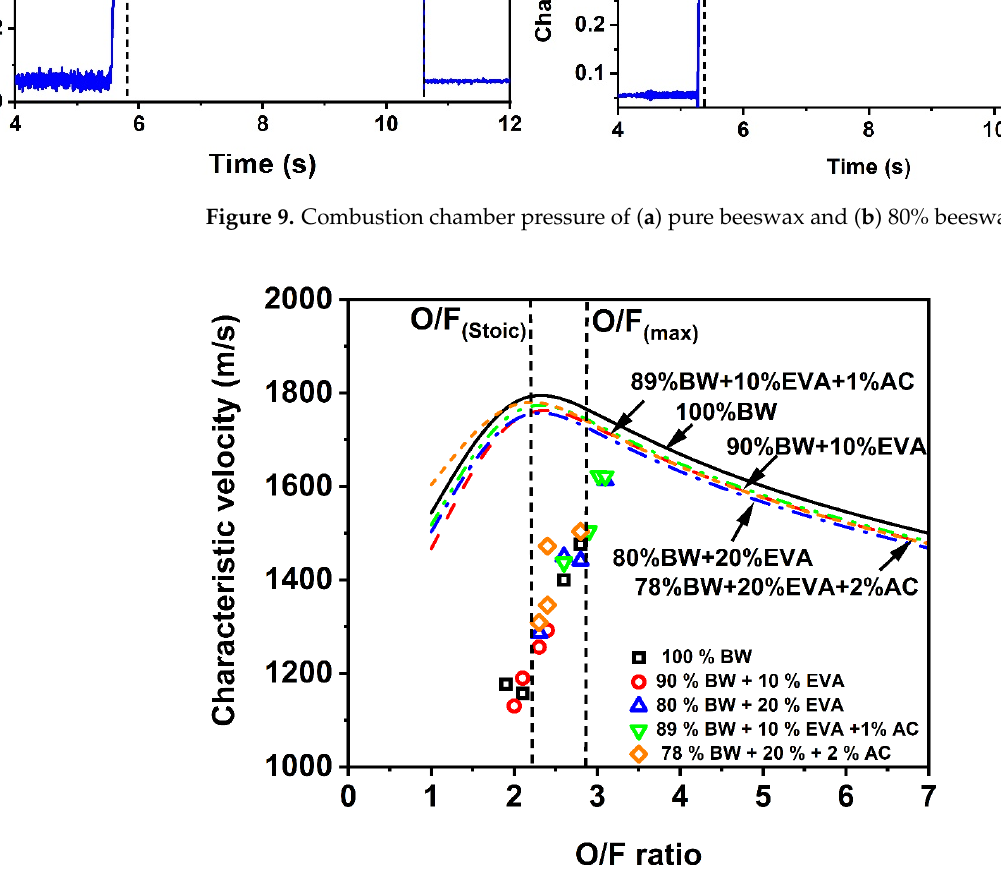
Figure 11. Combustion efficiency variation vs. O/F ratio for prepared fuels. The combustion efficiency of tested fuel compositions is found to be in the range of 62% to 94%. The combustion efficiency of BW-based fuel is improved when the hybrid motor is operated close to (O/F) stoic . In general, the combustion efficiency can be aug- mented by increasing the characteristic length (L*), oxidizer mass flux, and (O/F) stoic [37,38]. Figure 11 shows that the pure BW exhibited poor combustion efficiency for the corresponding O/F ratios. One of the drawbacks of using pure wax fuels is their generally